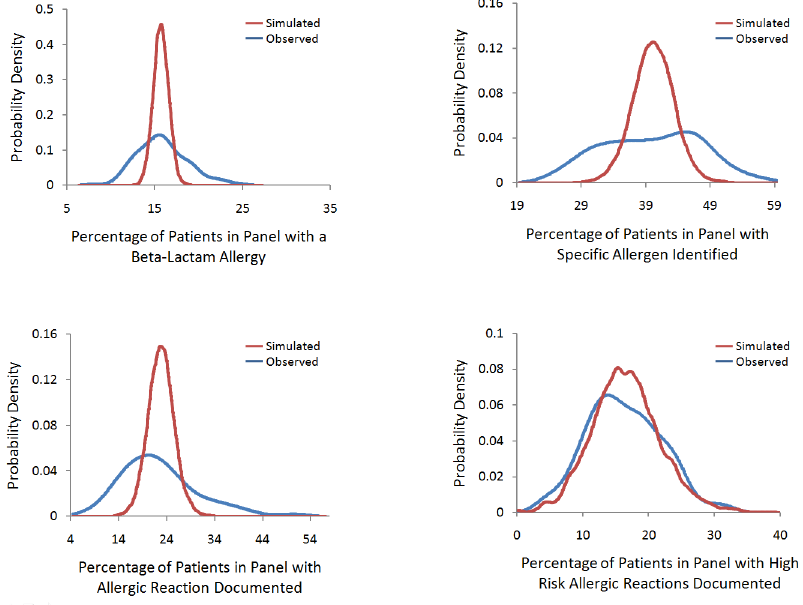
Fig 2. a-d. Observed vs. simulated expected frequency distribution of the percentage of patients with a beta- lactam allergy (Fig 2a), a specific beta-lactam allergen identified (Fig 2b), with characteristics of a beta-lactam reaction documented (Fig 2c) and with a high-risk beta-lactam allergic reaction documented (Fig 2d) by physician cohort. In the simulation, expected distribution was determined by holding patient panel size constant and randomly assigning patients as either having or not having the event based on the global event rate of all the patients in the study. The simulation was repeated 100 times and the distribution of the percentage of events in each physician ’ s patient panel was calculated. Levene ’ s test was used to compare the equality of variance between the observed and expected distributions.